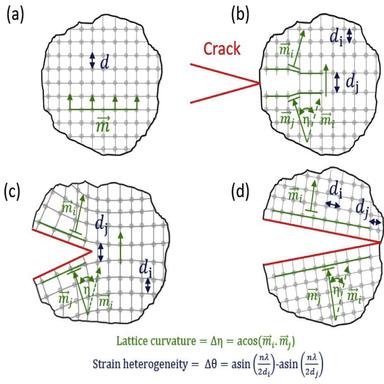
The evolution of the deformation in the lattice due to an approaching SFC is described through four stages (a) grain is away from the crack, shown with an idealized lattice as a reference case, (b) crack is impinging on the grain and emitting dislocations, (c) crack is propagating through the grain, (d) crack has propagated through the grain bifurcating it into two sub-grains. Lattice distortion is measured via two metrics: curvature in the planes of the lattice and the heterogeneity in the spacing of the l